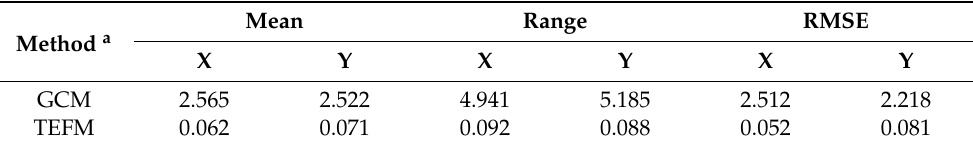
Table 3. Accuracy evaluation of centroid extraction algorithms for the footprint image. Method